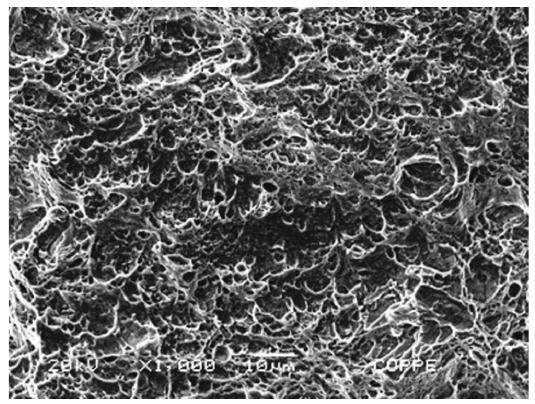
Figure 7. SEM image of specimen heat treated for 1 hour at 650 °C (42J at –46 °C – sub-size specimen 7.5